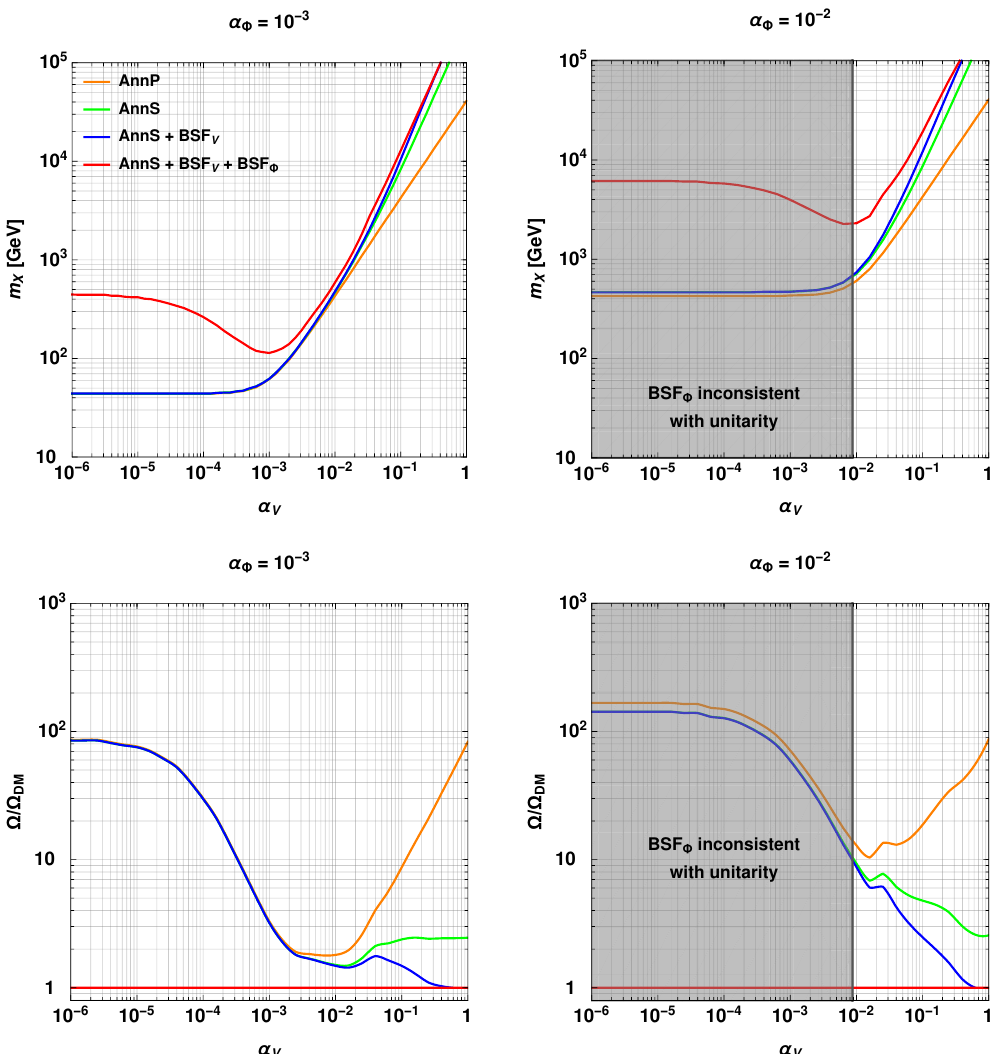
Figure 18 . Top: the relation between the DM mass m (cid:11) that reproduces the observed DM density, when considering di(cid:11)erent contributions to the DM V depletion. In the gray-shaded region, our computation of the BSF within a range of velocities. Bottom: the X; X y relic density when taking into account only some of the DM depletion processes, normalised to the observed DM density. For each value of (cid:11) chosen m such that the observed DM density is reproduced by the AnnS+BSF X (red line in plots